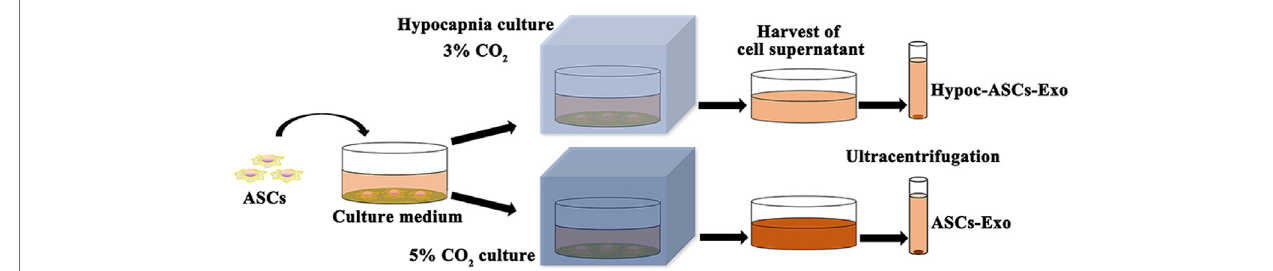
FIGURE 1 | Schematic representations of exosomes isolated from two cultured environments.